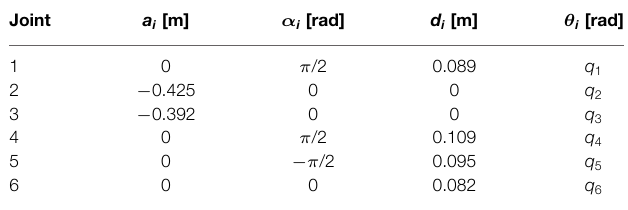
TABLE 4 | Table of the D–H parameters of the UR5 .